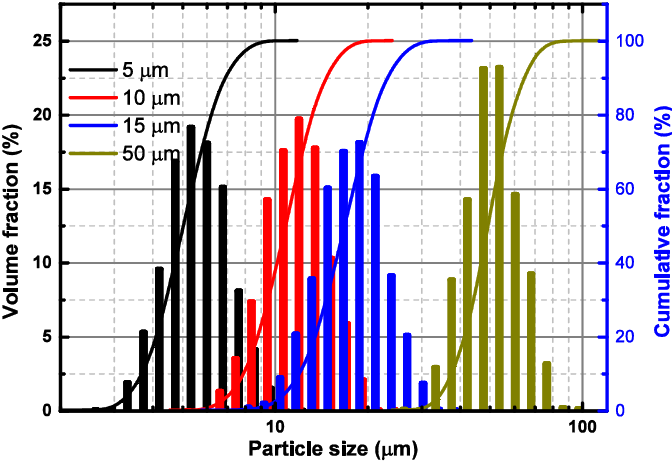
ff erent sizes, 5, 10, 15, and 50 µ